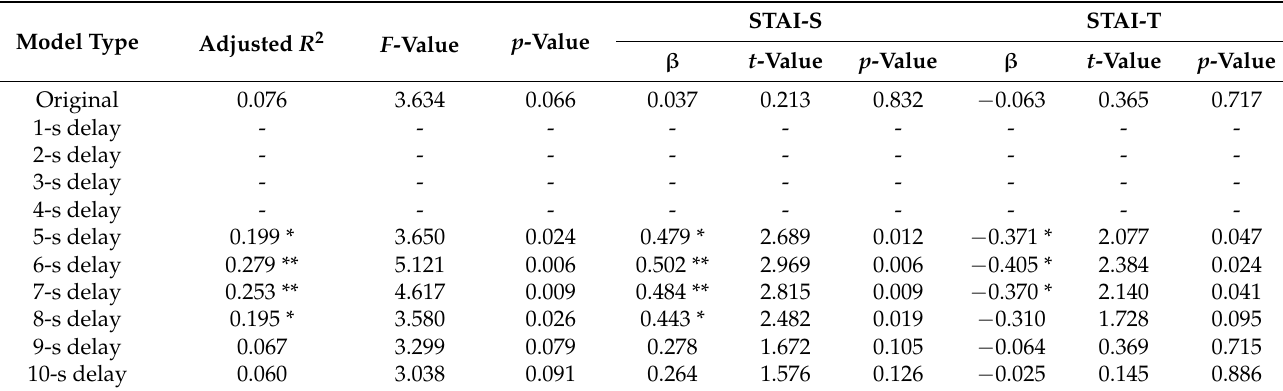
Table 3. Results from multiple regression analyses for the temporal pressure condition ( n = 33) concerning the associations between participants’ model fitting coefficients and self-reported anxiety scores.